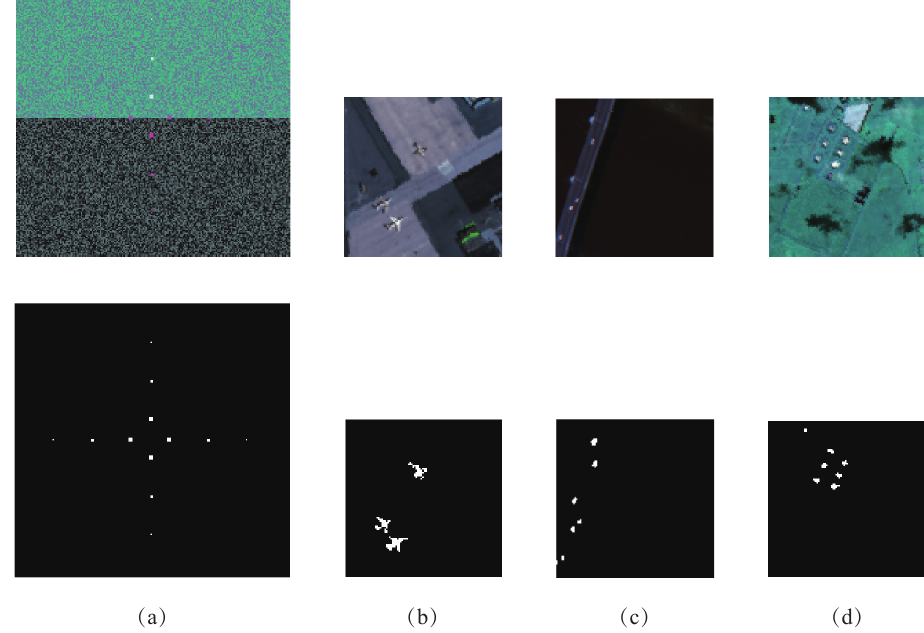
Figure 2. The pseudo-color images composed of 10th, 70th, and 100th spectral bands and their corresponding reference maps: ( a ) Simulated. ( b ) San Diego airport. ( c ) Pavia center. ( d ) Texas Coast